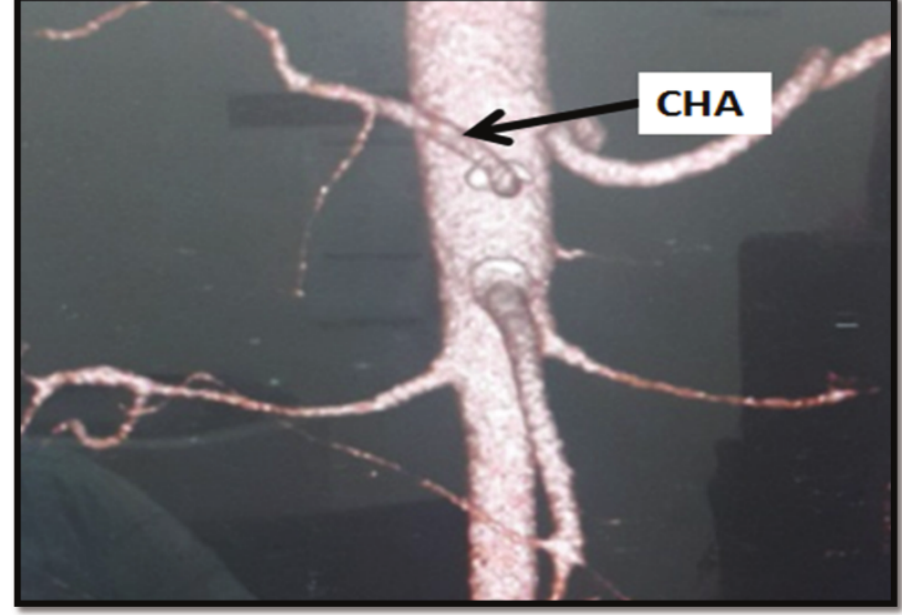
Figure 6 : CT angiography of Toshiba Aquilion 𝑇𝑀 64 slice (Toshiba Medical Systems, Nasu, Japan) showing the common hepatic artery arising from the